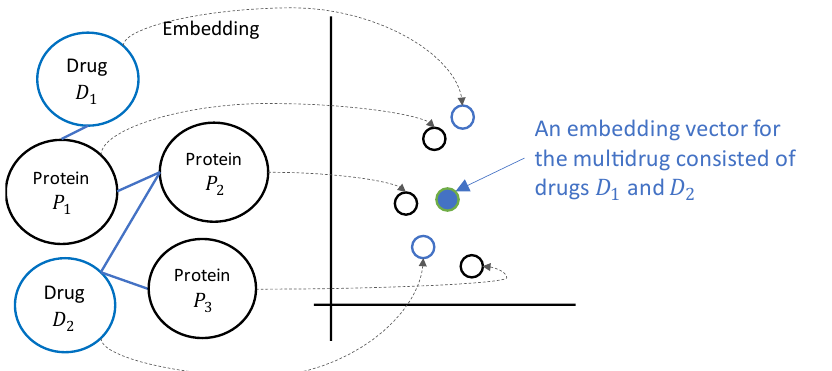
Figure 1. An illustration of the core idea of this study based on a toy example. The embedding vectors of single drugs, multidrug combinations, and proteins are constructed such that they exist in the same latent space. A multidrug is embedded in the position where the properties of its constituent drugs are superimposed.